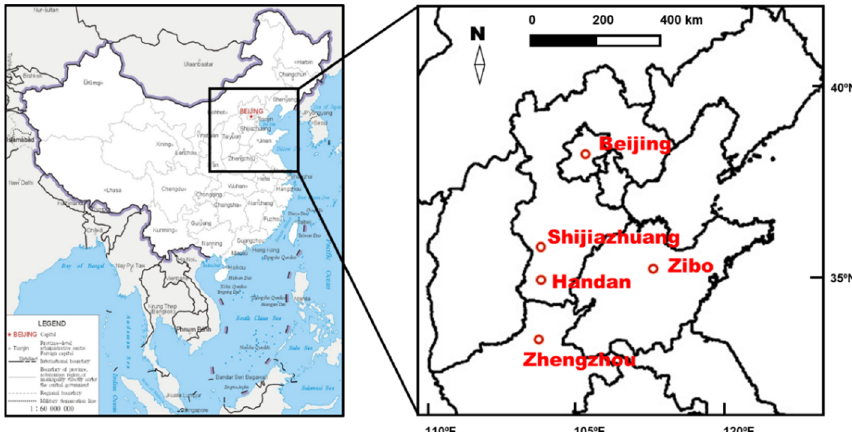
Figure 1. Locations of the study sites. Table 2. Description of the study